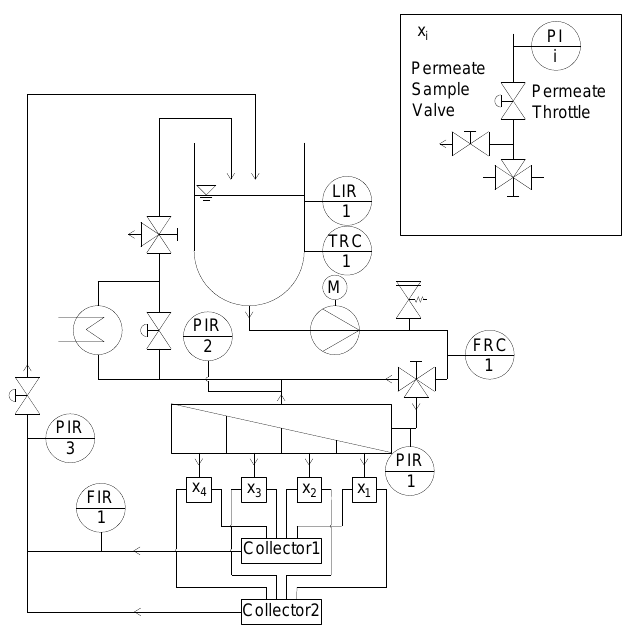
Figure 7. Modified pilot plant, x 1 –x 4 refer to the set of components and their interconnection, as depicted in the top right box.